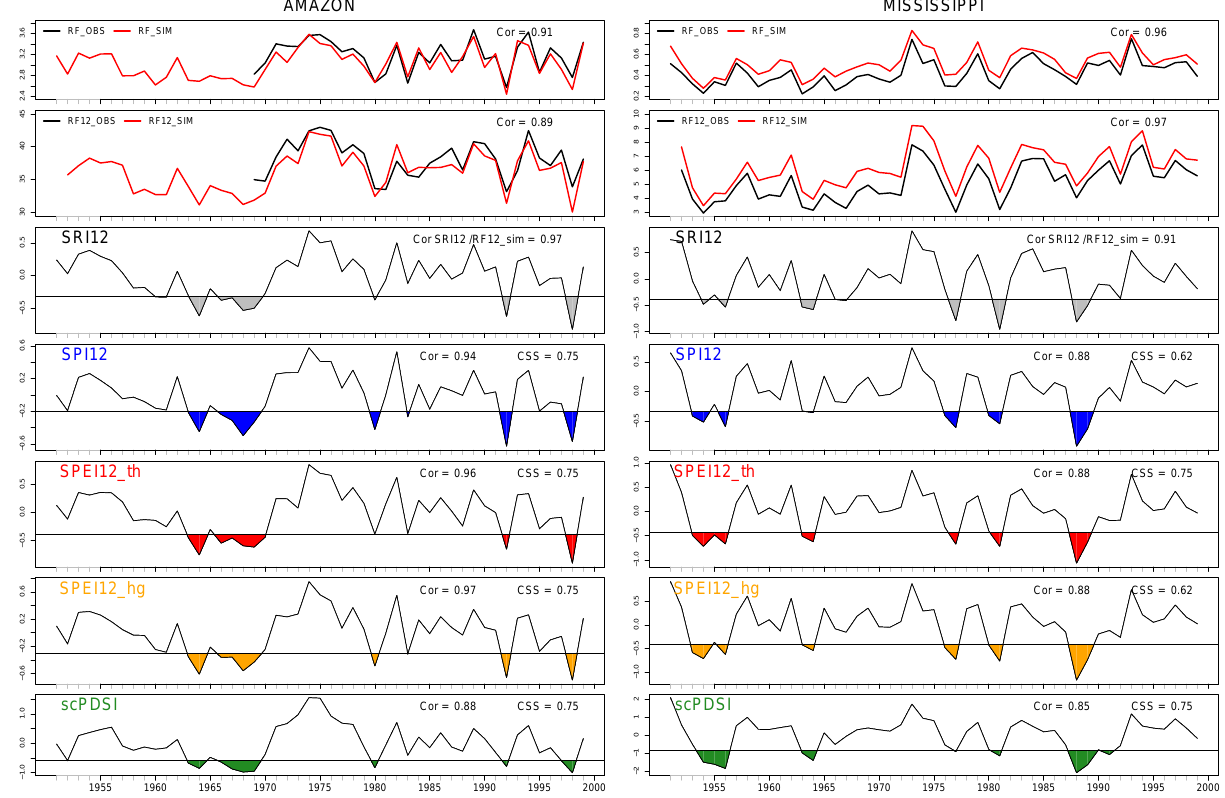
Fig. 1. Annual mean time series from 1951 to 1999 of river flow (RF mmday − 1 ), cumulated river flow over 12 months (RF12 mmday − 1 ), detrended SRI12, and detrended meteorological drought indices (SPI12, SPEI12_th, SPEI12_hg and scPDSI). The correlation and the CSSs between SRI12 and each meteorological index are indicated in the top right corner of each plot. For each index, droughts are defined under the 20th percentile and are